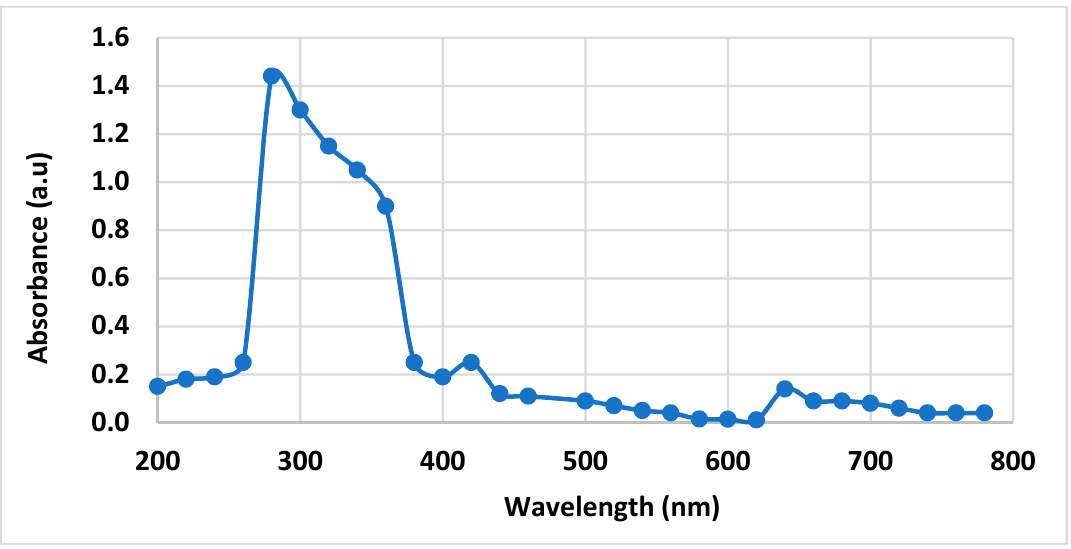
Figure 1. Absorption spectrum of raw wastewater from paper industry in the UV/Vis range.